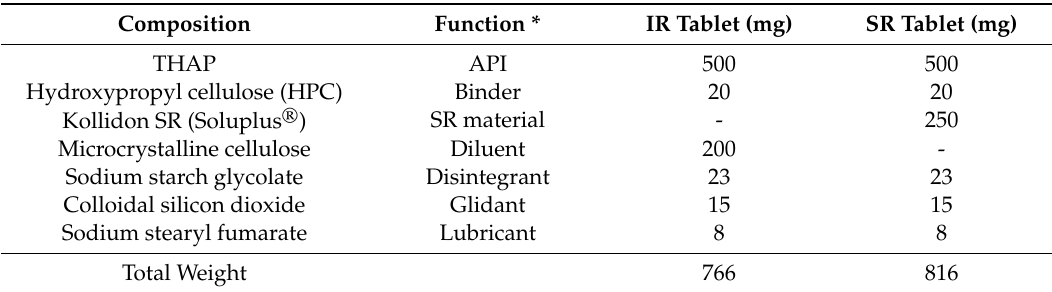
Table 5. The compositions of IR and SR THAP tablets for dogs.